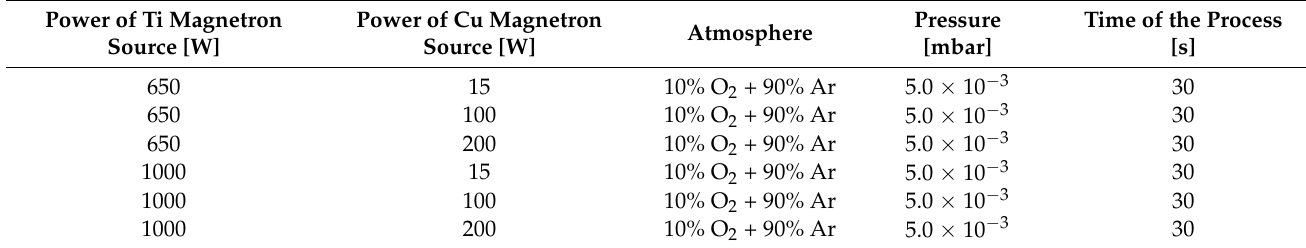
Table 1. Deposition parameters for TiO 2 + CuO